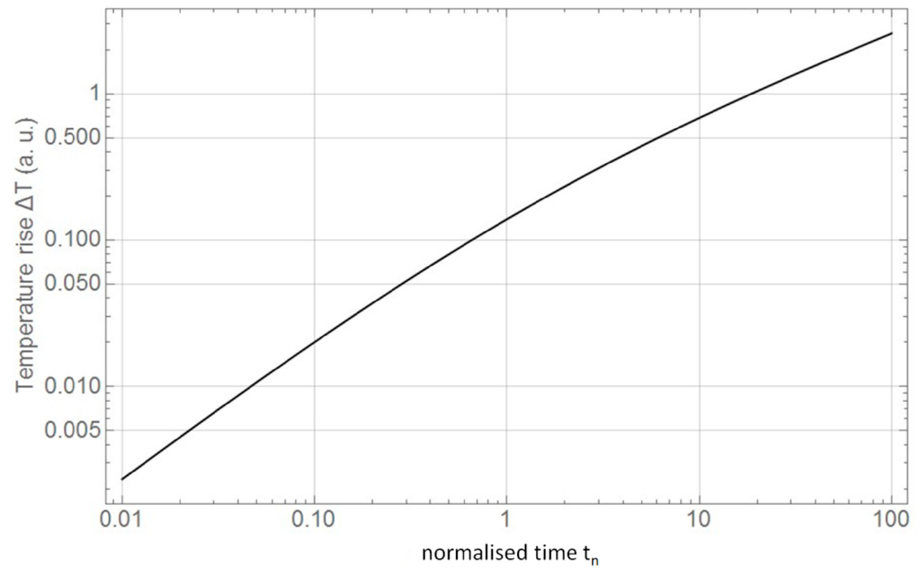
Figure 2. Temperature rise ∆ T as a function of the normalised time t n calculated based on Equation